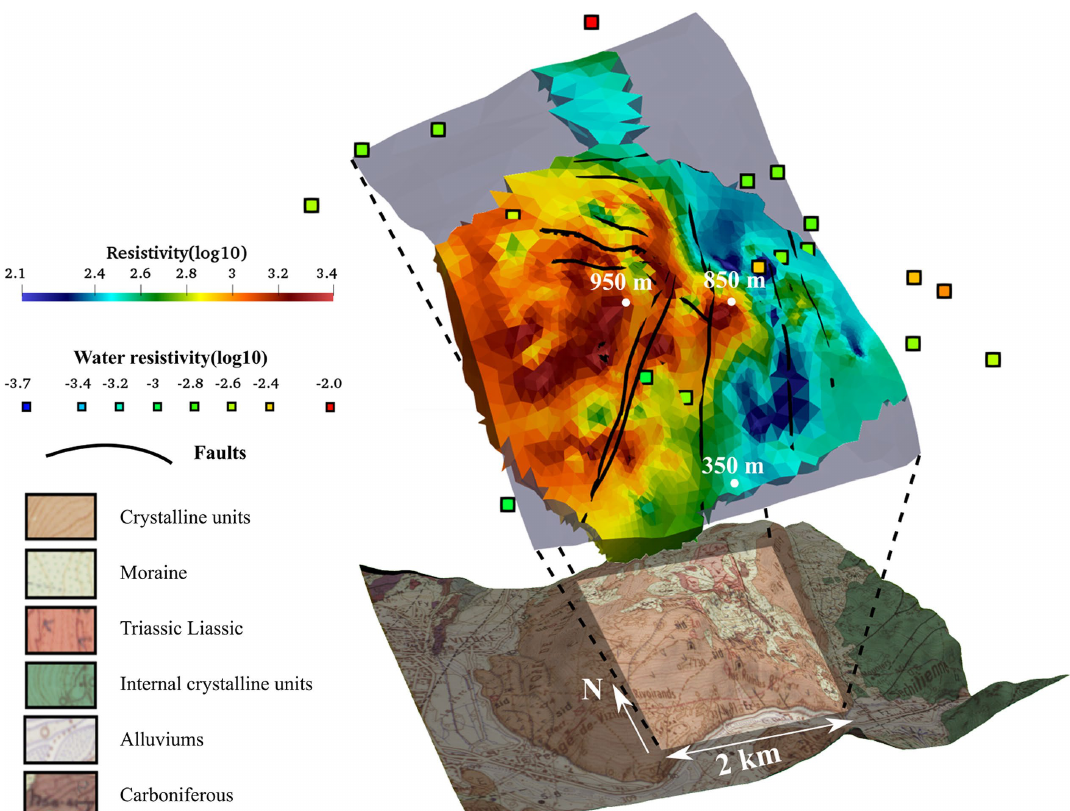
Figure 10. 3D representation of the interpreted model superimposed on the geological map of the slope. The squares represent the resistivity (log10) of the surface waters sampled in spring or at surface runoff locations. The black lines represent the major faults. (Reprinted with permission from [41], Copyright (2019) Oxford University Press).